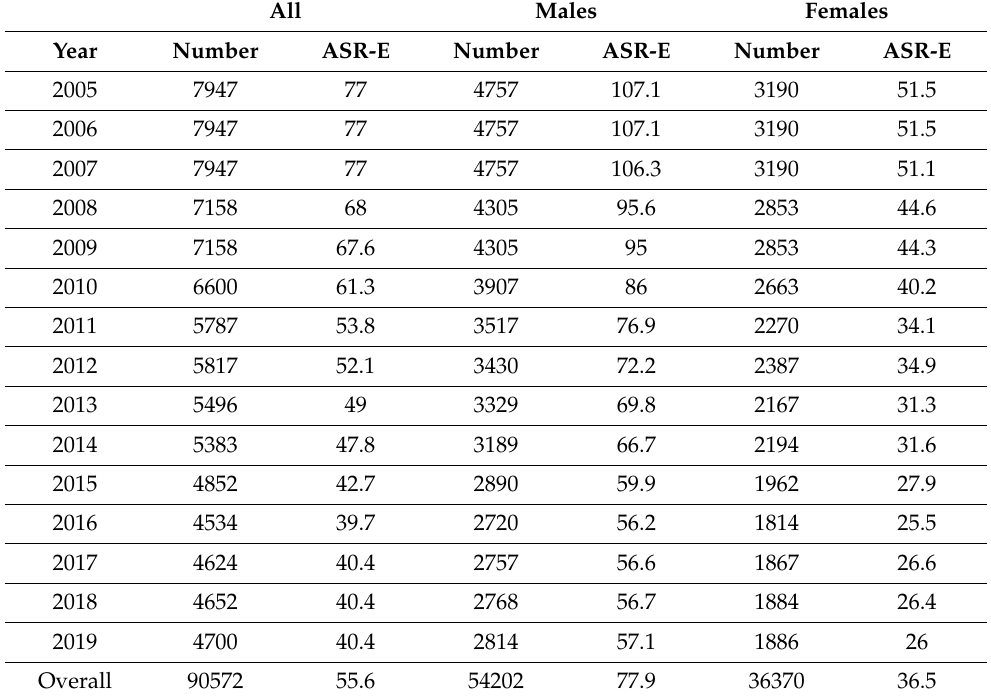
Table 1. Number of deaths and ASR-E in men and women,